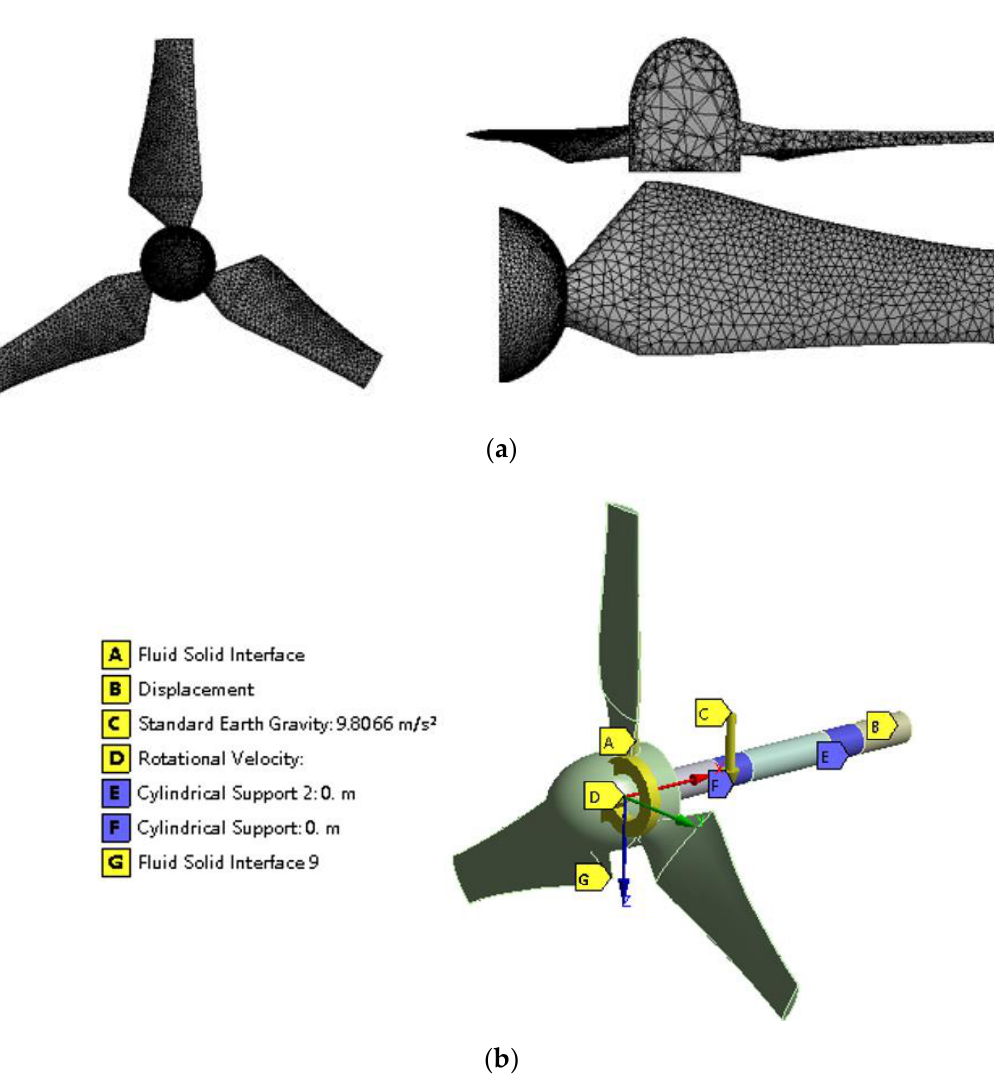
Figure 3. Mesh division and constraint setting of solid domain model: ( a ) mesh of solid domain and ( b ) constraints on solid domain .